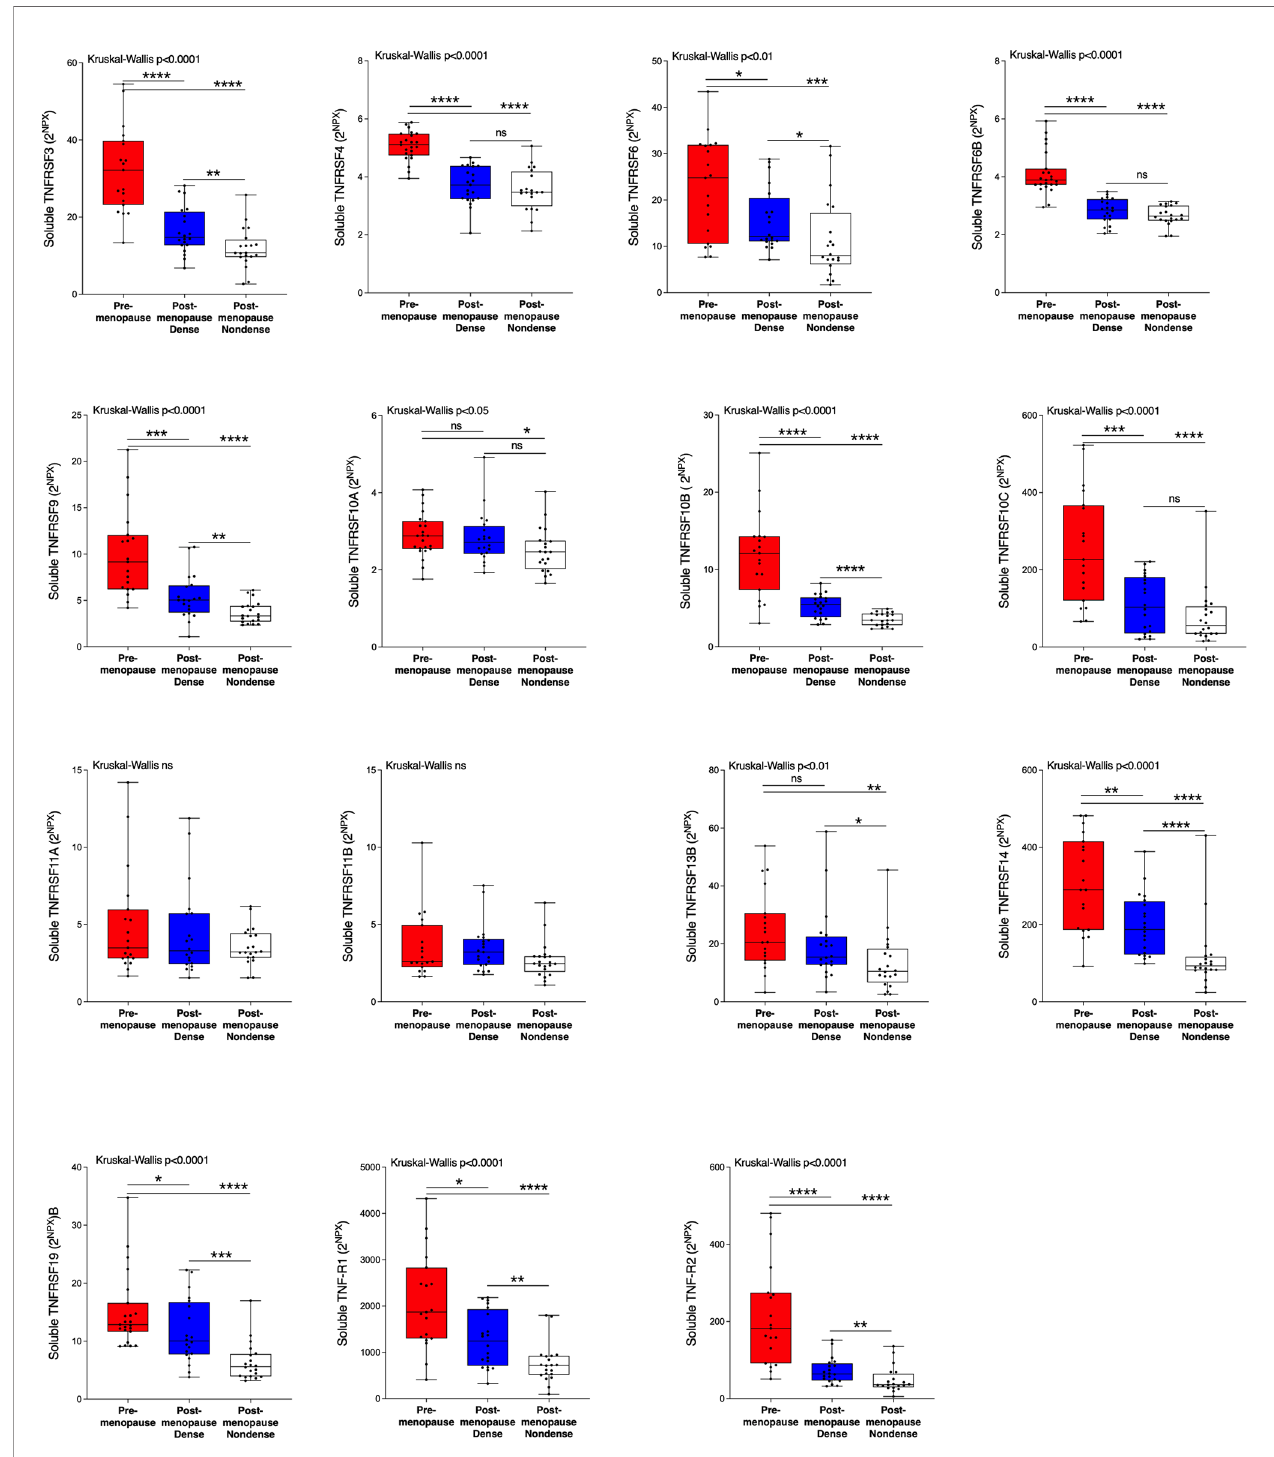
FIGURE 4 | Extracellular levels of soluble TNFRSF in vivo in healthy normal breast tissue of premenopausal women and postmenopausal women with different breast densities. A total of 59 women underwent microdialysis of their left breast; 40 postmenopausal healthy volunteer women, attending the regular mammography-screening program categorized as either having dense (n = 20, blue boxes) or nondense breasts (n = 20, clear boxes) and 19 premenopausal women (red boxes). Proteins were quanti fi ed using proximity extension assay. Data represents extracellular local protein abundance in linear values (2 NPX as described in the Methods section). A signi fi cant Kruskal-Wallis was followed by Mann Whitney U-test. Data are displayed as box plots with median and 10 – 90 percentile. *P < 0.05, **P < 0.01, ***P < 0.001, ****P < 0.0001, ns, not signi fi